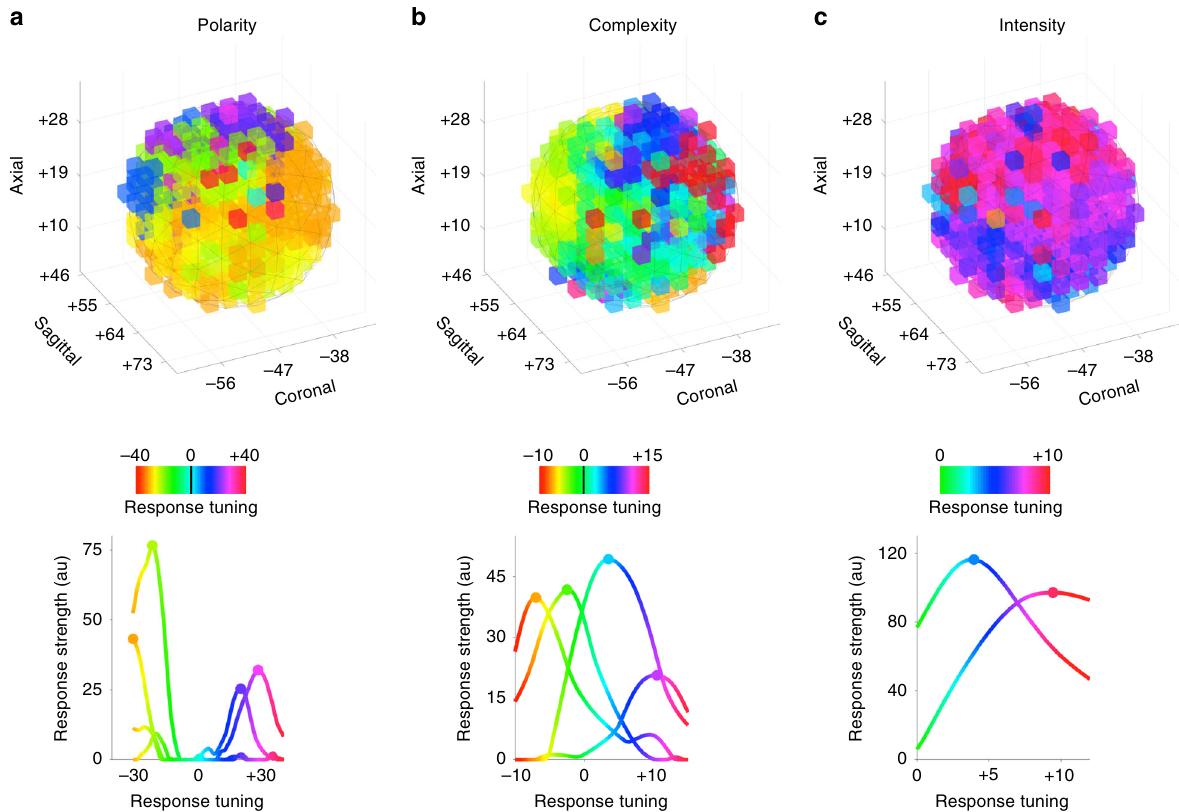
Fig. 6 Population receptive fi eld estimates in right TPJ. Response selectivity maps of right TPJ voxels for a polarity, b complexity and c intensity. Preferred responses of distinct populations of voxels were obtained using non-negative matrix factorization (Supplementary Fig. 9). Components explaining at least 5% of the variance were plotted as a tuning curve (lowermost row) after averaging all the possible tuning width values for each emotion dimension score. The maps of voxel selectivity were consistent with the topography obtained from the original gradient estimation for the three emotion dimensions (polarity: ρ = 0.547, p -value = 0.001; complexity: ρ = 0.560, p -value < 0.001 and intensity: ρ = 0.596, p -value < 0.001; permutation test; n = 428